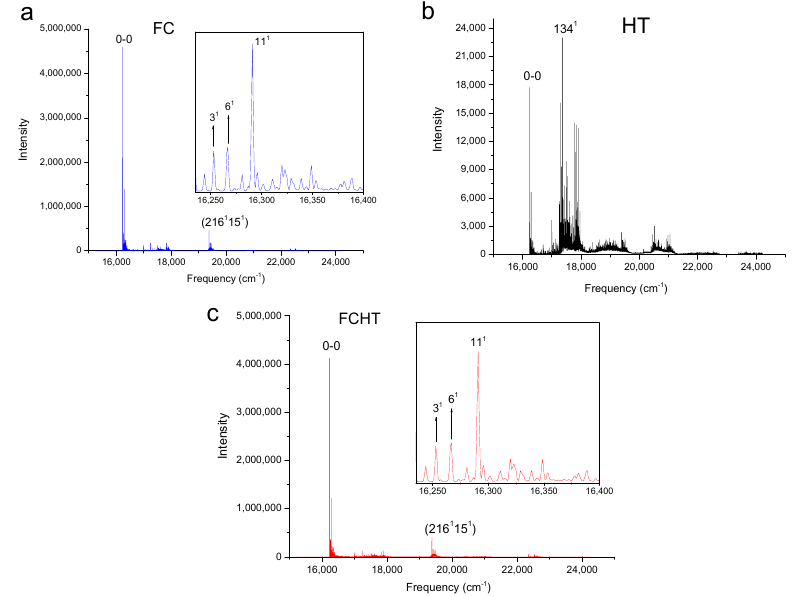
Figure 2. Calculated vibronic absorption spectra of chlorophyll a using the CAM-B3LYP functional and 6-31G(d) basis set, including the Franck–Condon (FC) contribution ( a ), Herzberg–Teller (HT) contribution ( b ), or both FCHT ( c ). The insets magnify specific regions of the spectra associated with assigned vibronic transitions.